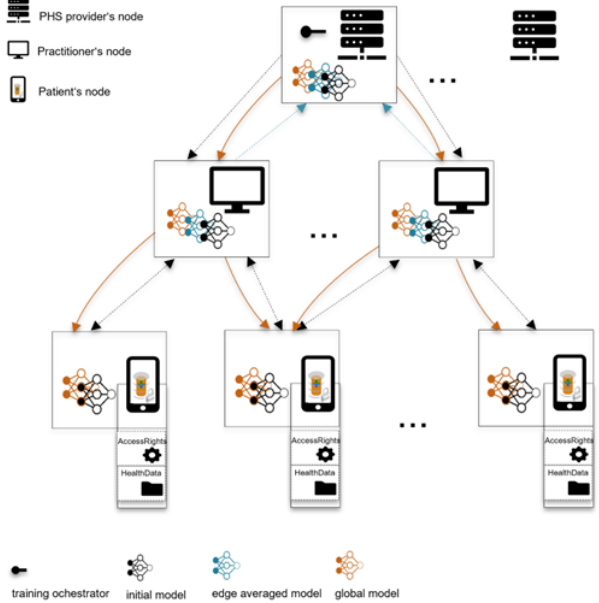
Figure 4. ML model training and hierarchical aggregation of model parameters. (i) PHS provider (global aggregator) orchestrates the training process and sends an initial model to practitioner nodes (local aggregators), (ii) local aggregators send the initial models to their patients’ edge nodes, (iii) edge nodes perform a few training epochs and commit model updates to the practitioners’ nodes, (iv) local aggregators aggregate local models of their clusters and commit them to the global aggregator, (v) global aggregators aggregate edge models and forward the global model to local aggregators, (vi) local aggregators send the global model to patients’ edge nodes for prediction or further